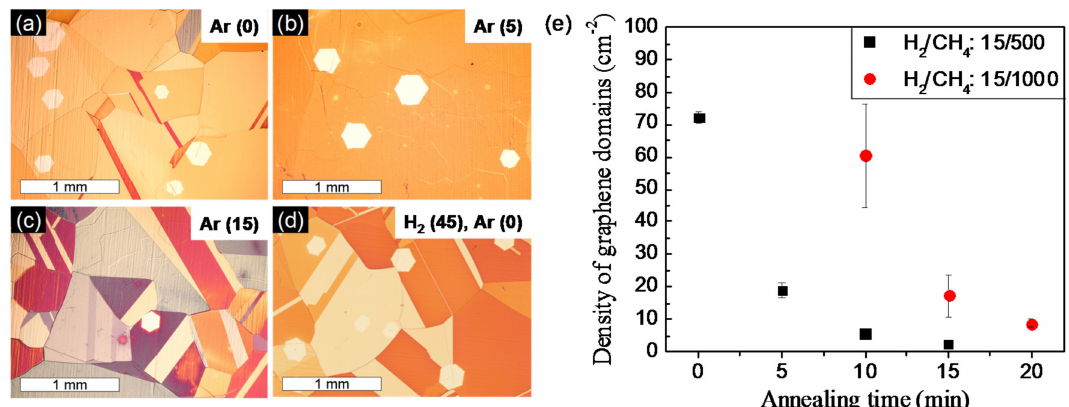
Figure 2. Effect of Ar annealing on density of graphene domains. ( a – c ) Optical microscope images of CVD graphene on Cu with different Ar annealing time (0, 5, and 15 min), while H 2 annealing time was fixed at 15 min; ( d ) CVD graphene grown after H 2 /Ar annealing for 45 min without Ar annealing; ( e ) Dependence of average density of graphene domains on Ar annealing time with two different flow rates for the growth. Square (black) and circle (red) plots correspond to the gas flows of 15/500 and 15/1000 sccm of H 2 /diluted CH 4 in Ar (H 2 /CH 4 ), respectively. Density of graphene domains is drastically decreased by Ar annealing for both growth